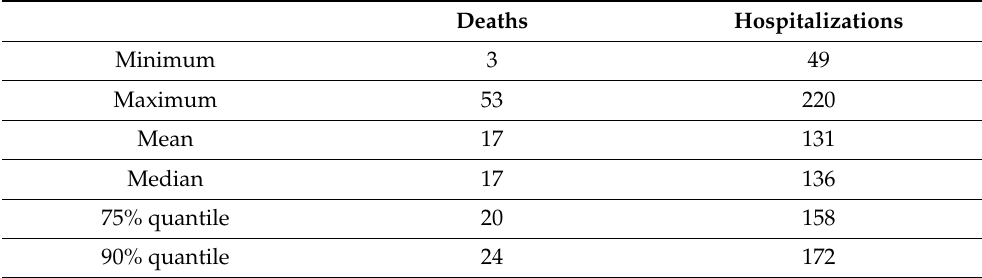
Table 2. Descriptive statistics for daily CVD deaths and hospitalizations in Montreal.